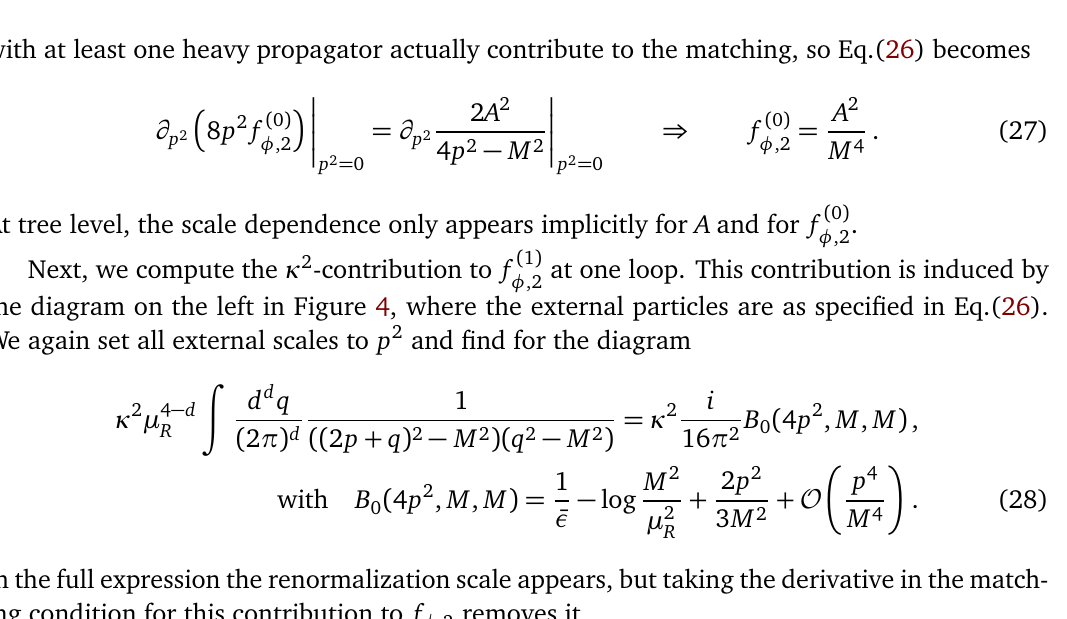
Figure 4: Feynman diagrams contributing to f contribution. Right: Diagram yielding a A 2 λ corresponds to the Higgs field, whereas the solid line corresponds to the